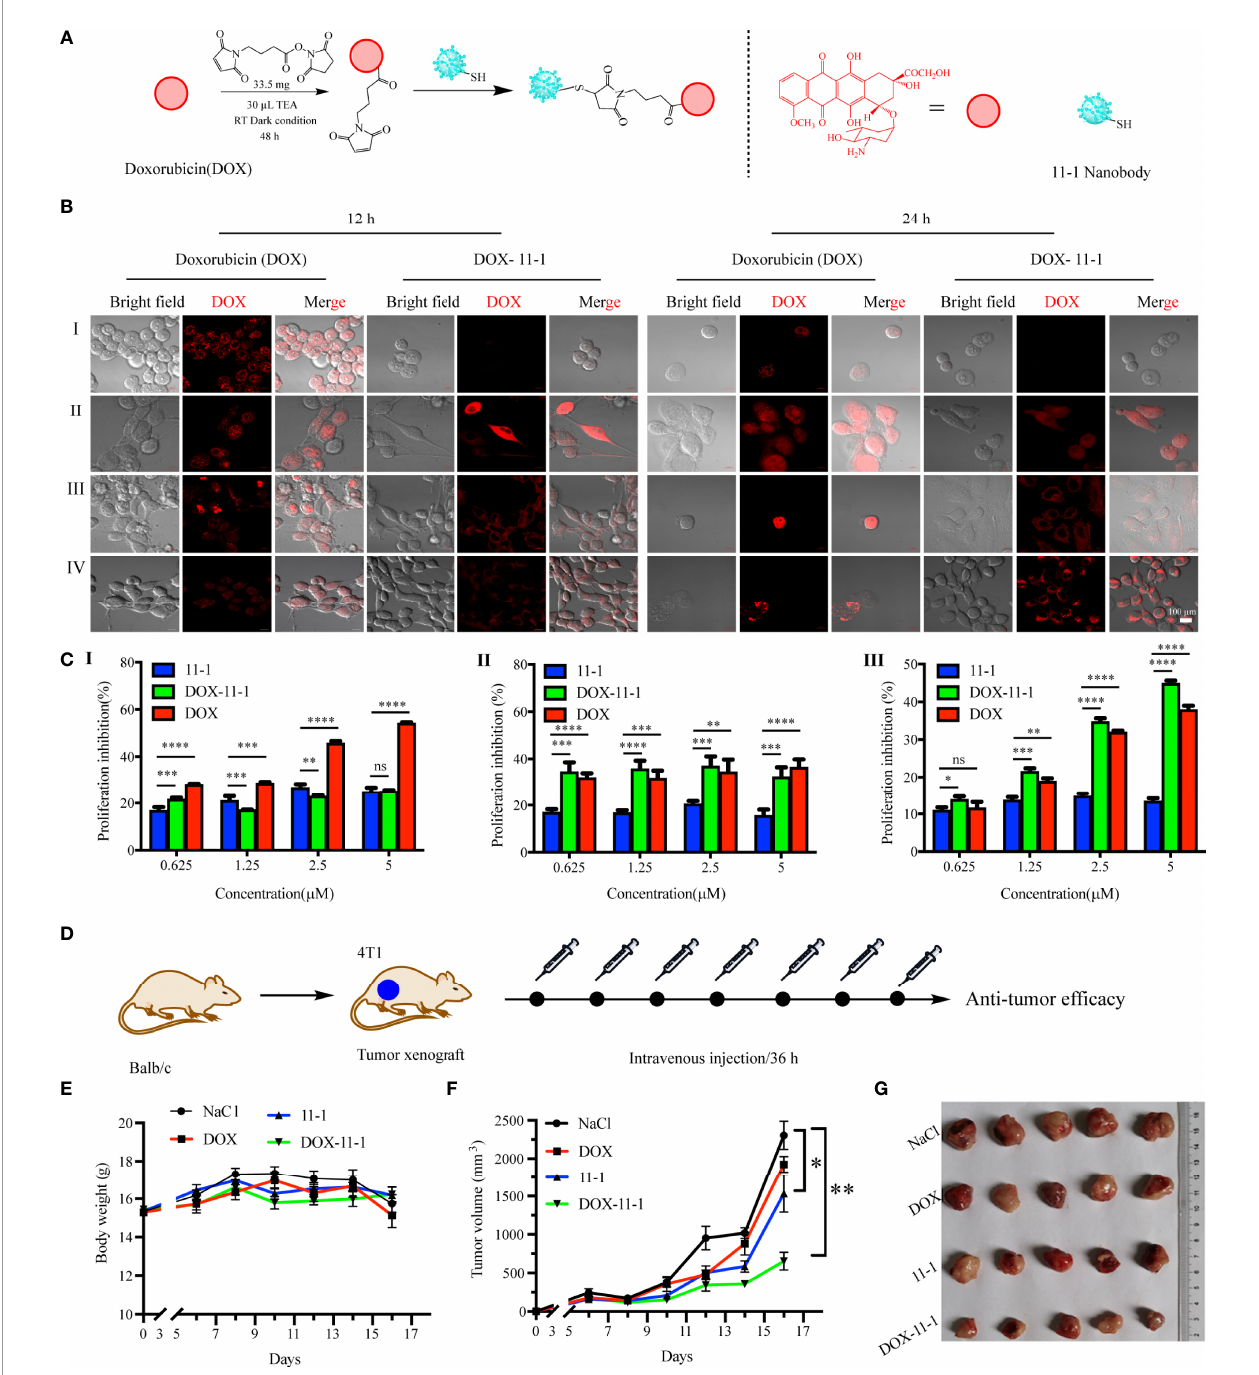
FIGURE 5 | The antitumor ef fi cacy of 11-1, free DOX, and DOX – 11-1 in vitro and in vivo assays. (A) The scheme of synthesis DOX – 11-1. (B) The distributions of free DOX and DOX – 11-1 in different cell lines were observed by confocal laser scanning microscopy. (I) 293T, (II) U87, (III) HeLa, and (IV) 4T1 cells were treated with free DOX or DOX – 11-1, and the fl uorescence signal was observed by confocal laser scanning microscopy in indicated time points. Scale bar = 100 m m. (C) Antitumor effects of Nb 11-1, free DOX, and DOX – 11-1 on different cells. Proliferation inhibition rates for 293T (I), U87 (II), and 4T1 (III) cells at 24 h after incubation with Nb 11-1, free DOX, and DOX – 11-1, determined by MTT assay. (D) The scheme of DOX – 11-1 antitumor ef fi cacy. (E) The body weight change of mice bearing 4T1 xenografts via the treatment of 11-1, free DOX, DOX – 11-1, and saline, respectively. (F) The tumor volume was signi fi cantly inhibited in DOX – 11-1 compared with another group at 16 days. (G) The tumor photographs were shown at 16 days. Comparisons between two groups were calculated using one- or two-tailed Student ’ s t -tests, using GraphPad Prism software. Data are reported as mean ± SEM. Number of replicates ( n = 5). *p < 0.05, **p < 0.01, ***p < 0.001, ****p < 0.0001, ns, no signi fi